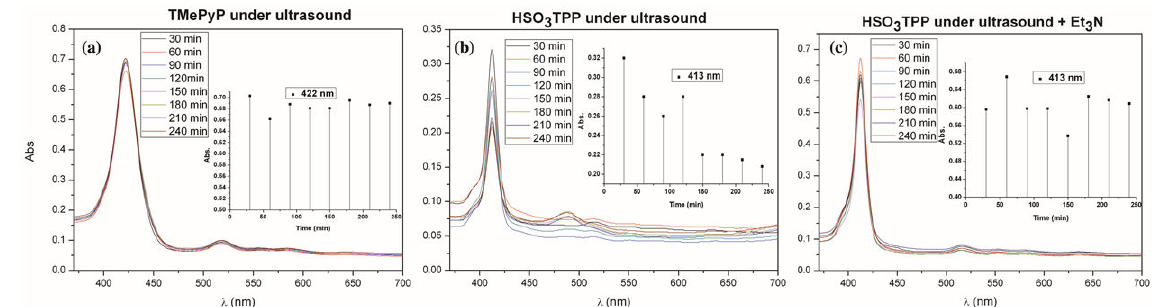
Figure 6. UV-Vis spectra of ( a ) TMePyP and ( b ) 4-SO 3 HTPP in water under ultrasound irradiation for 240 min. (c) UV-Vis spectra of 4-SO 3 HTPP in water under ultrasound irradiation for 240 min measured after the addition of 1 drop of Et 3 N. Inset: Absorption at the Soret band maximum vs.